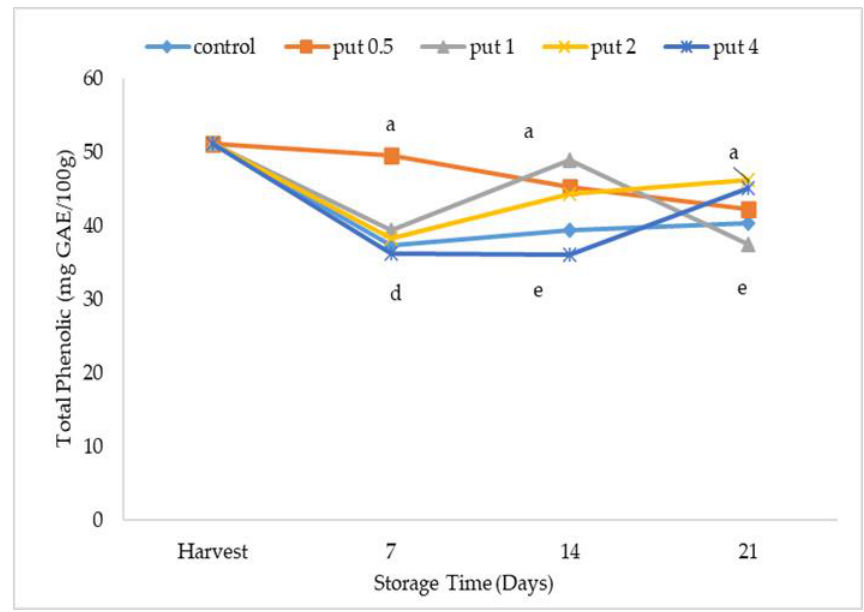
Figure 6. Effect of putrescine treatment on total phenolics of fig fruit during cold storage. Put 0.5, 1, 2 and 4 indicates putrescine doses of 0.5 mM, 1 mM, 2 mM, and 4 mM, respectively. According to the Tukey test, p < 0.05 does not differ between the same letters in the same harvest period.